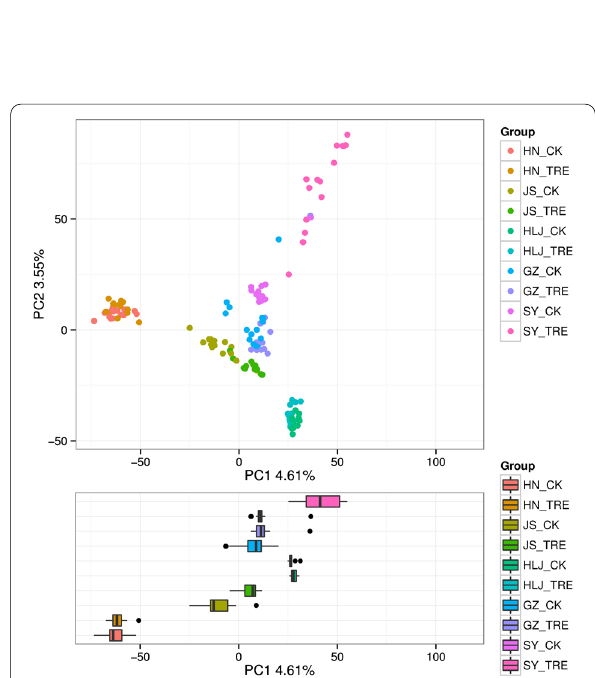
Fig. 3 Beta-diversity indices (PCA plot) of bacterial community structure in BIO-treated and untreated soil samples at five rice paddy sites. The HN_CK, HN_TRE, JS_CK, JS_TRE, HLJ_CK, HLJ_TRE, GZ_CK, GZ_TRE, SY_CK and SY_TRE represent BIO treatment and untreated control at the five rice paddy sites in